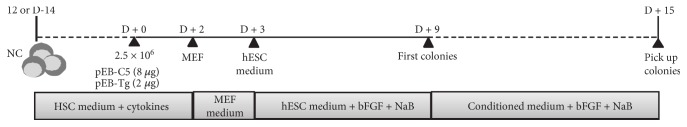
Scheme of the reprogramming protocol used in the generation of iPSCs from adult MNCs. After nine days of nucleofection, the first colonies were visible and after approximately 15 days, the first picking was performed.